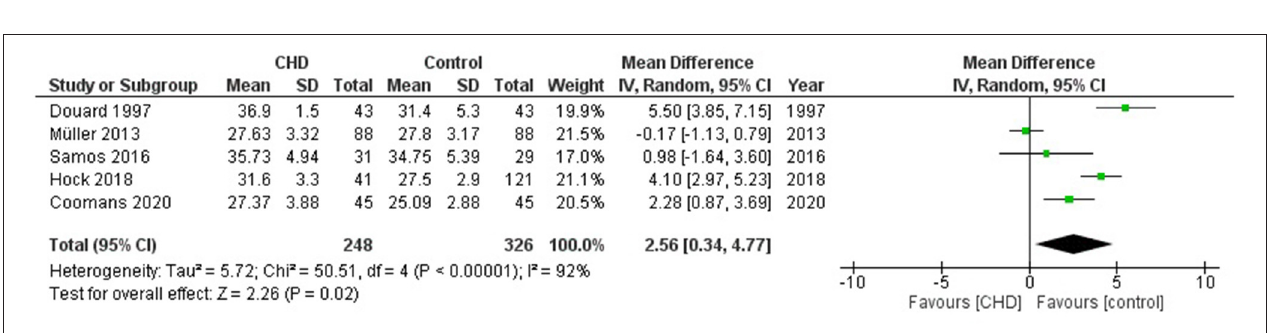
FIGURE 5 | Forest plot for mean maximum workload for CHD in children and adolescents and healthy controls. Subanalysis by age.